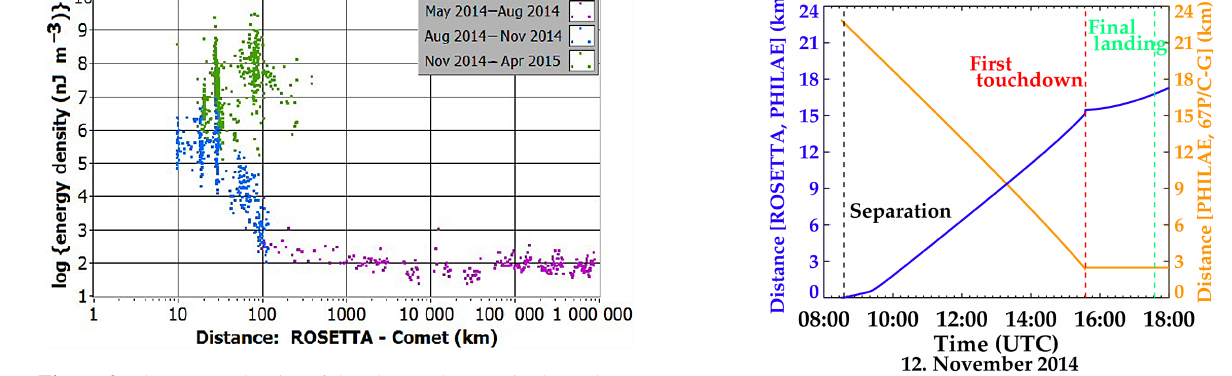
Figure 3. Temporal evolution of the distance between ROSETTA and PHILAE and also between PHILAE and 67P/C-G (centre) dur- ing the descent to 67P/C-G on 12 November 2014. The shown tra- jectories have been generated using the latest nominal kernels being